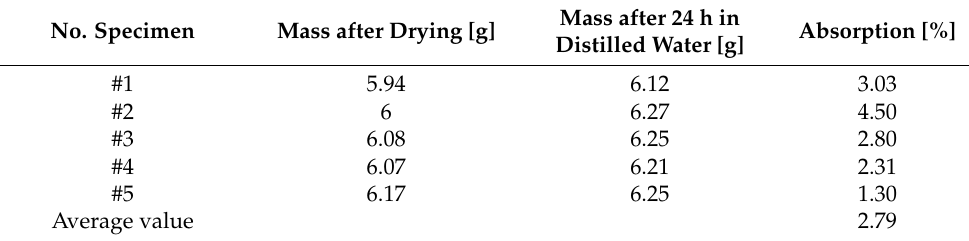
Table 6. Distilled water absorption of Ecoflex 00-10 test specimens.